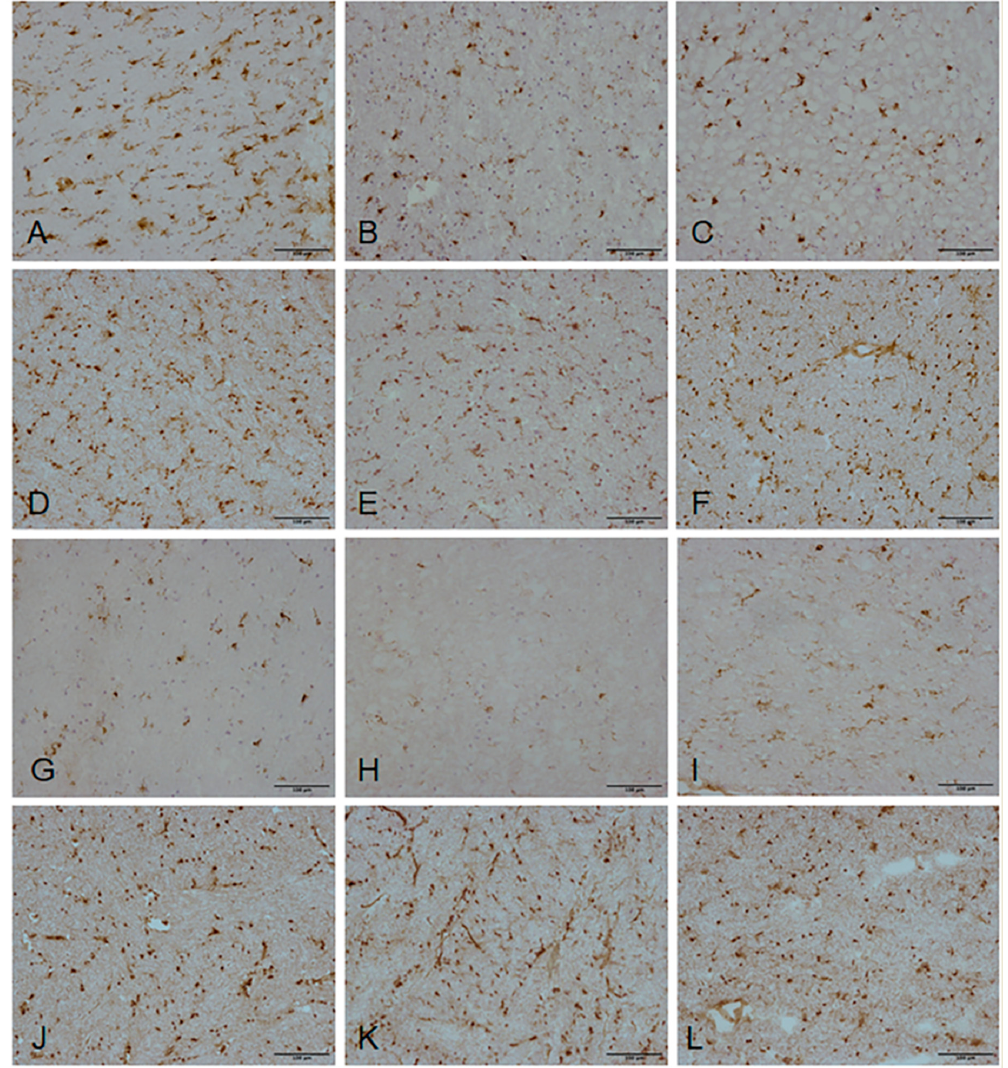
Figure 4. Histological validation candidate gene expression changes. Expression of proteins encoded by candidate genes highlighted by both microarray and NanoString datasets was assessed. ( A – C ) CD74, ( D – F ) IL-1 β , ( G – I ) CD163 and ( J – L ) CD86 immunolabelled cell bodies and processes of microglia in all periventricular white matter groups: non-lesional control white matter ( A , D , G , J ); “pre-lesional” white matter ( B , E , H , K ); and PVL ( C , F , I , L ). Scale bar represents 100 µm.